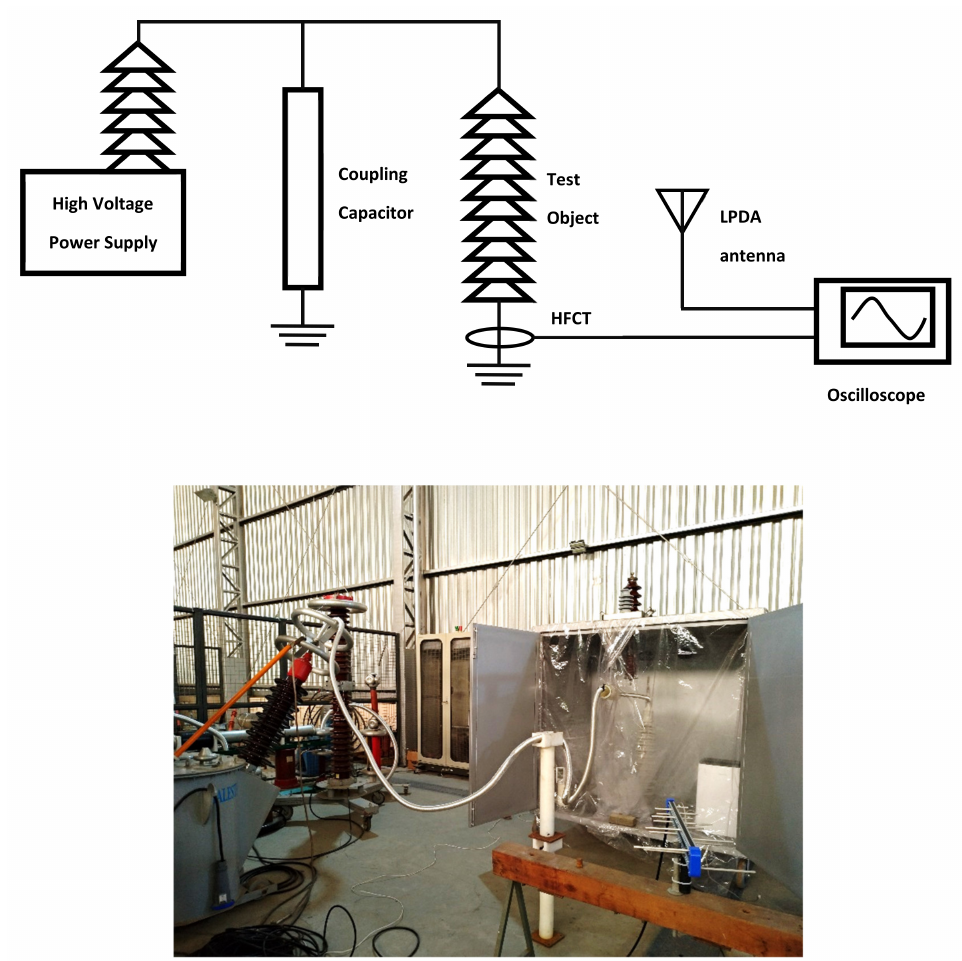
Figure 11. ( Top ): the schematic of the experimental setup, showing a basic partial discharge laboratory test circuit, and an LPDA antenna and an HFCT being used as the PD detectors; ( bottom ): a photo of the actual experimental setup, showing the high voltage power supply on the left, the coupling capacitor on the back, the fog chamber to which the test object is subjected, and the antenna in blue on the right.